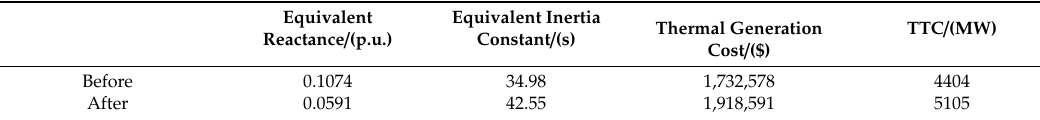
Table 8. Comparation of relative electrical parameters, generation cost and TTC before and after optimizing the day-head generation